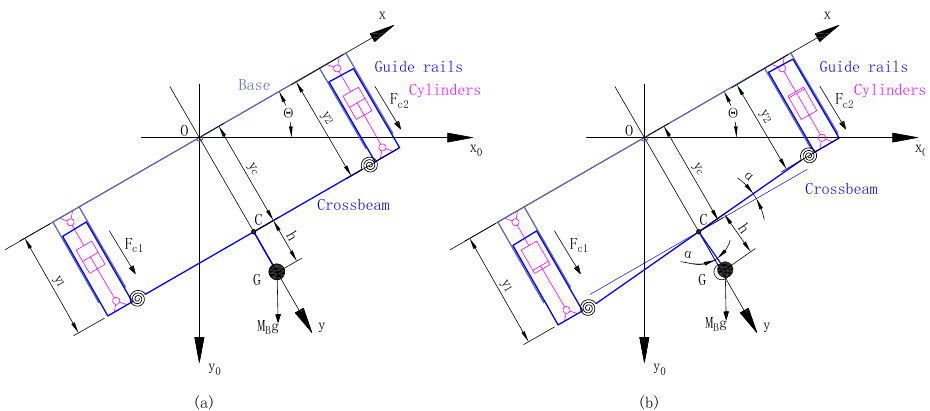
Figure 3. Schematic diagram of the dual-cylinder lifting gantry at a certain rotational angle of Θ . ( a ) General configuration of the lifting gantry. ( b ) Linear and rotational motions of the lifting